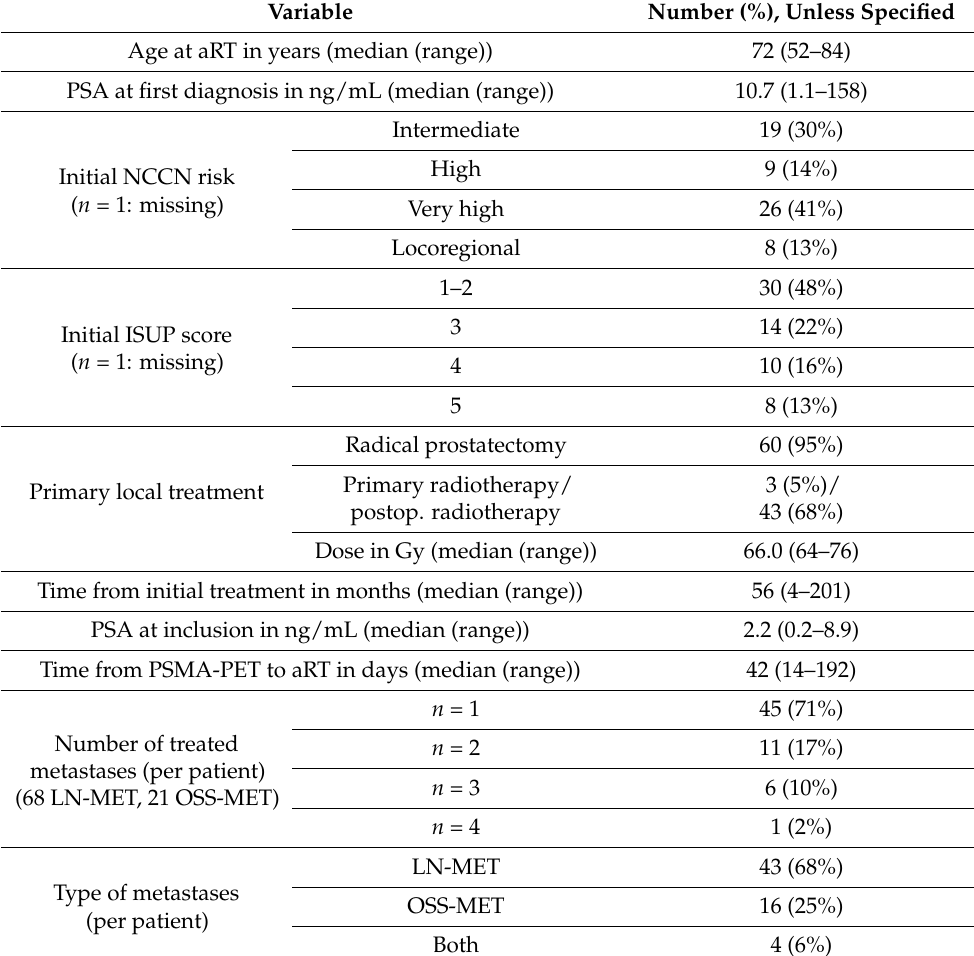
Table 1. Patient, tumor, and treatment characteristics ( n =